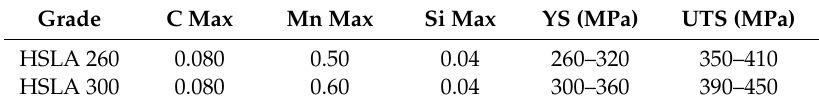
Table 3. Composition (% in mass) and mechanical properties of steel grades studied.